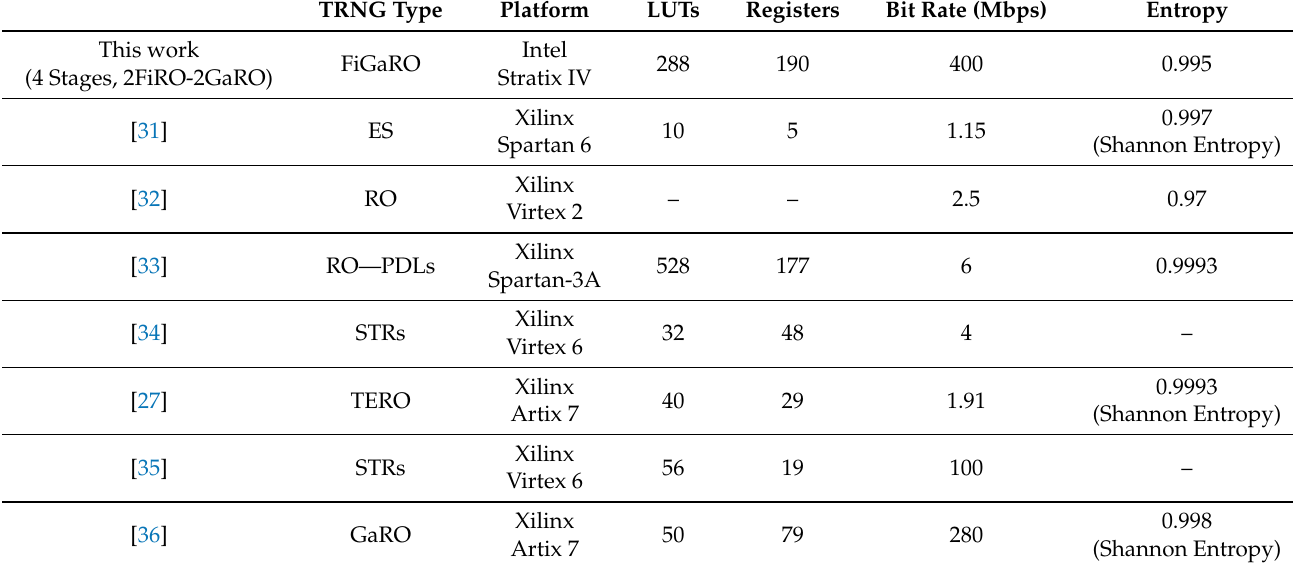
Table 5. Comparison among the proposed TRNG with other TRNG implementations on